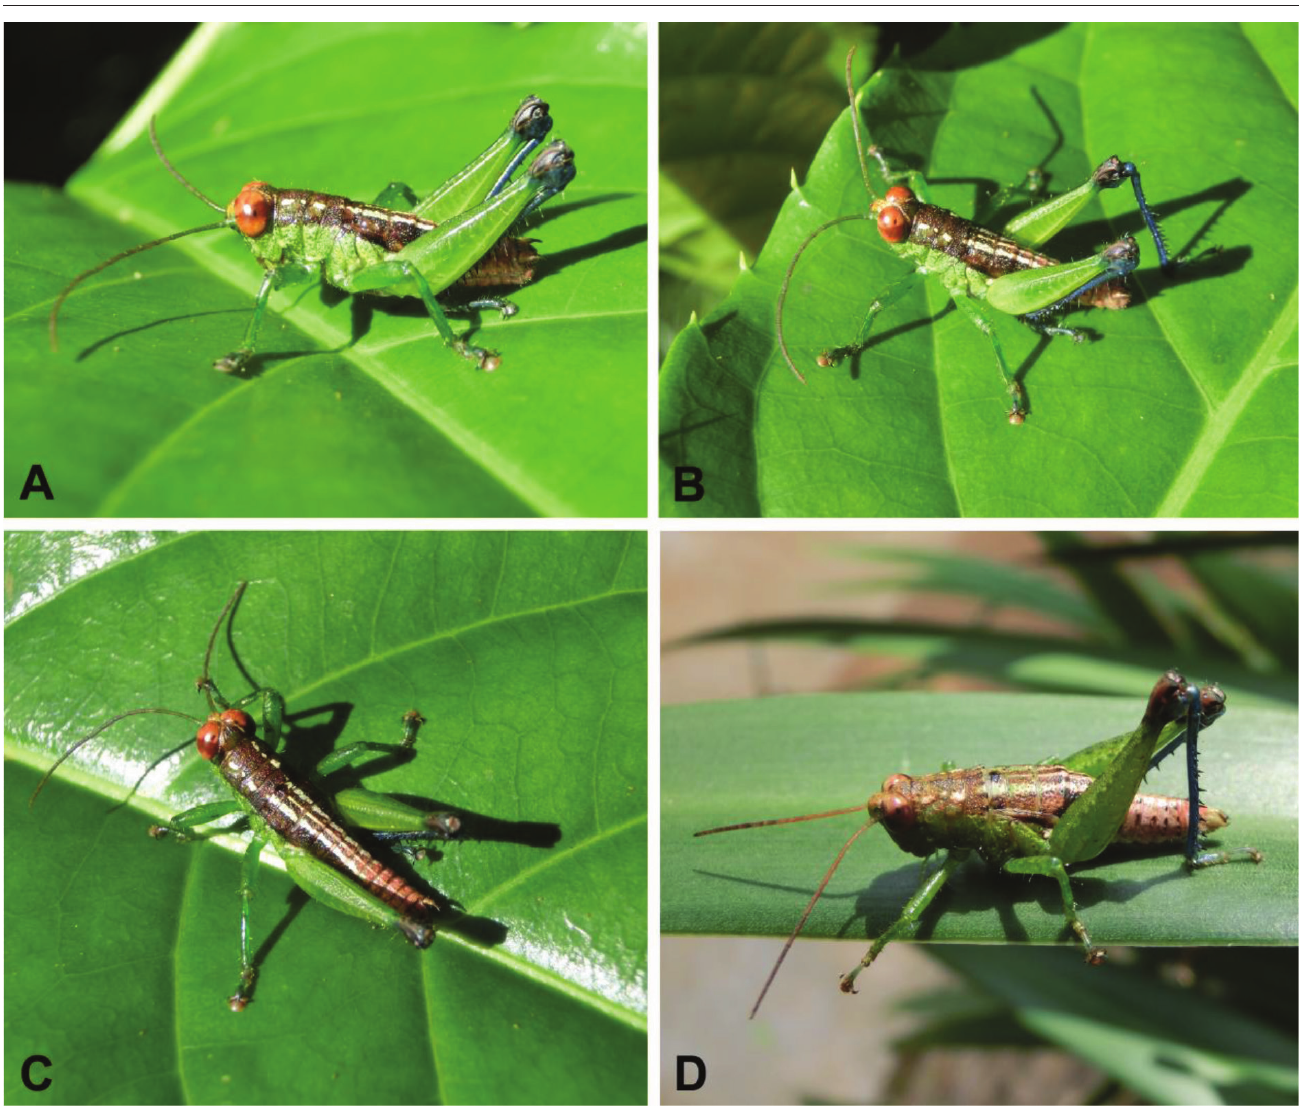
Fig. 1. Physocrobylus venetus sp. nov. A–C. Male; and D. Female. Thorax. Thorax strongly wrinkled and impressed with dots, deeply crossed by two sulci; lateral carinae absent. Anterior mar- gin evenly rounded; posterior margin medially incurved (Fig. 2A). Prosternal tubercle conical, laterally compressed. Tegmina strong- ly reduced, elongate lobes with narrow anterior part, slightly wid- ening posteriorly, broadly rounded and with reduced venation (Fig. 3C). Alae absent. Legs. Fore and mid femora round, with largest diameter in the middle; unarmed. Hind femora stout; unarmed. Fore and mid tib- iae also roundish, unarmed except for black spurs; fore tibiae with three outer and two inner spurs, mid tibiae each with an outer and an inner pair of spurs. Hind tibiae with double row of dorsal long spines, white at the base, with black tips; on inner side, two large and laterally flattened spurs, on outer side, a pair of smaller but also enlarged stout spurs. Tarsi of light color; mid tarsal segment very short, the other two segments about 3 times as long as the middle